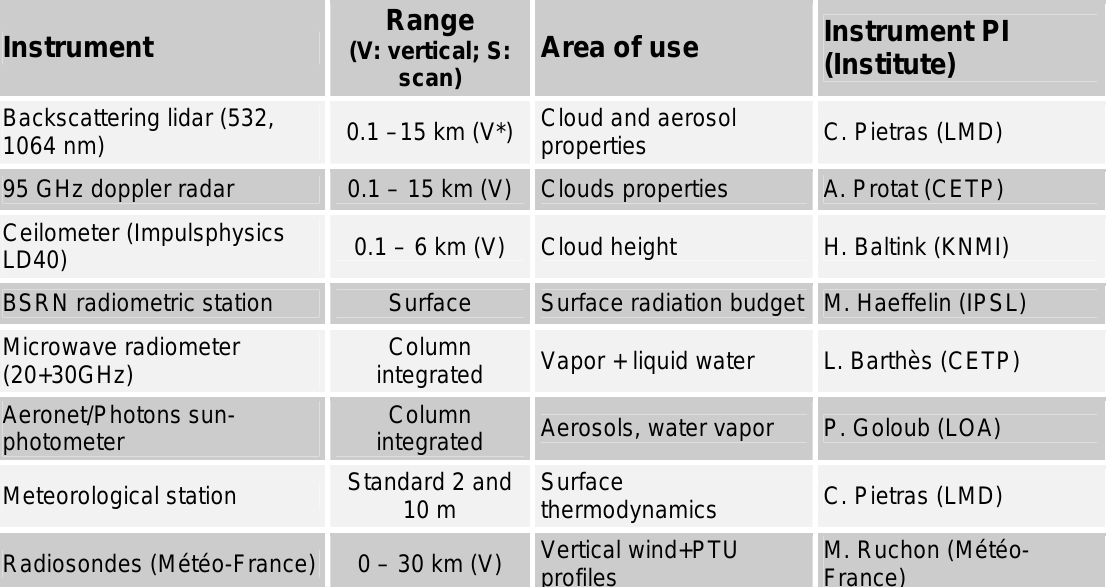
Table 3: List of instruments developed at IPSL and collaborating institute that operate at SIRTA in the context of specific field campaigns